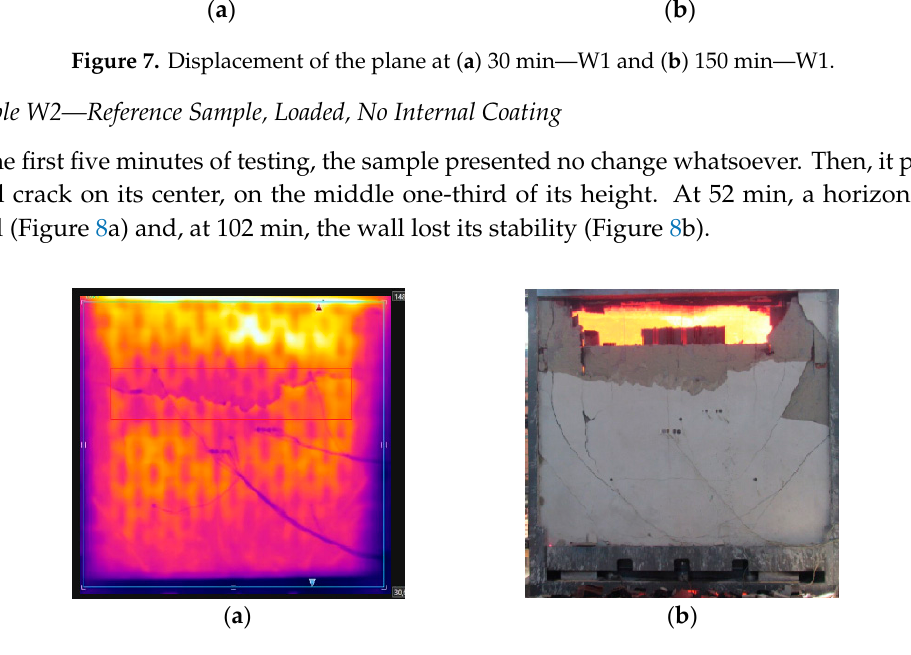
Figure 8. ( a ) Horizontal crack at 52 min and ( b ) loss of structural stability at 102 min.